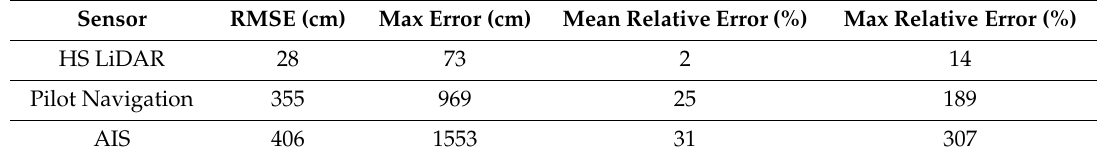
Table 6. Comparison of positioning errors.